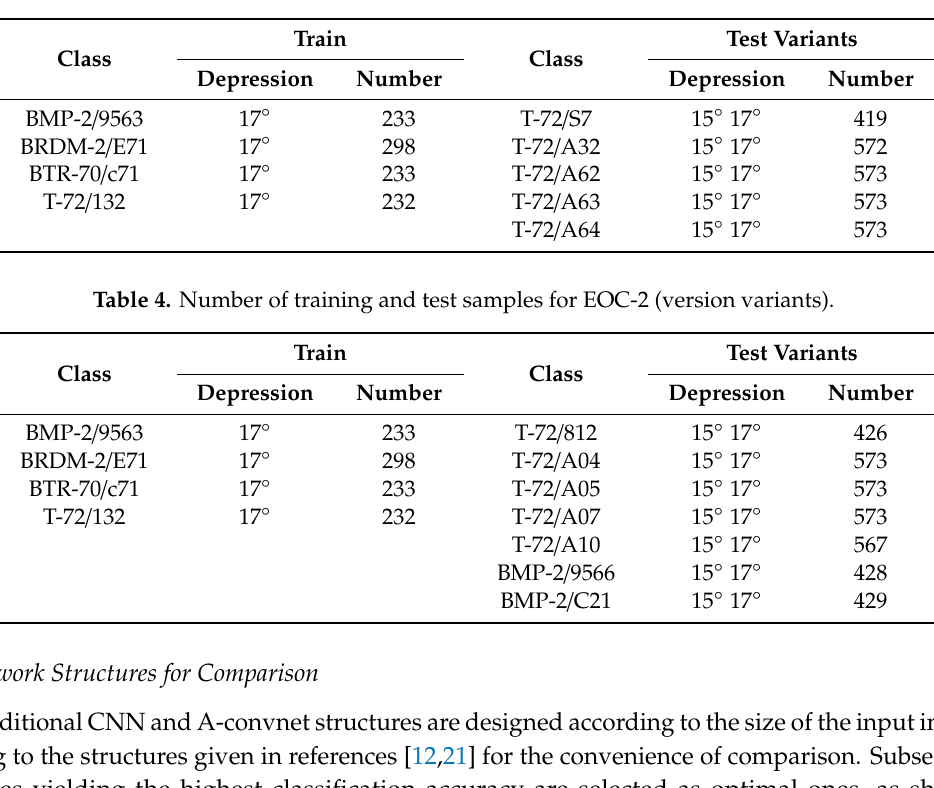
Table 3. Number of training and test samples for EOC-2 (configuration variants).